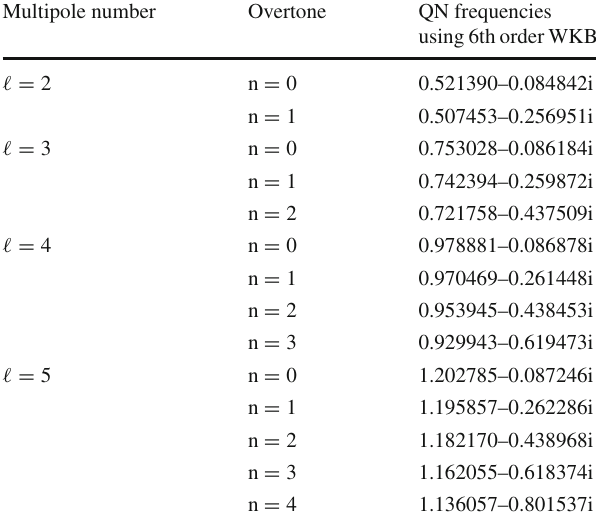
Table 1 Electromagnetic QN frequencies for the Bardeen de-Sitter black hole spacetime as a function of (cid:12) and n for q = 0 . 57 and